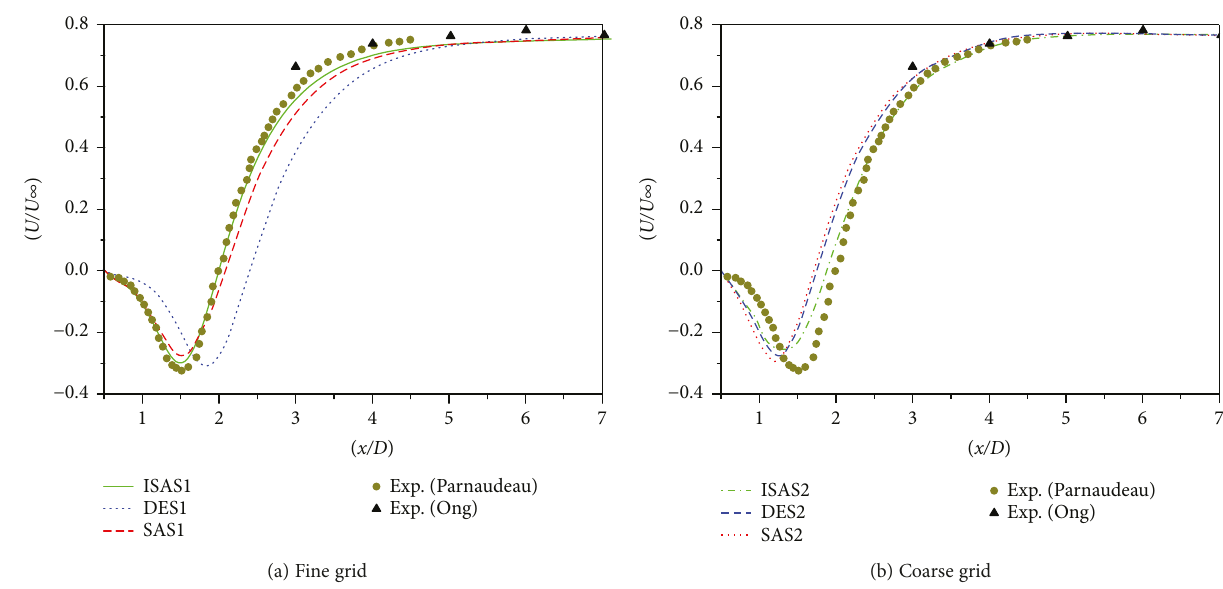
Figure 6: Distribution of mean streamwise velocity along the wake